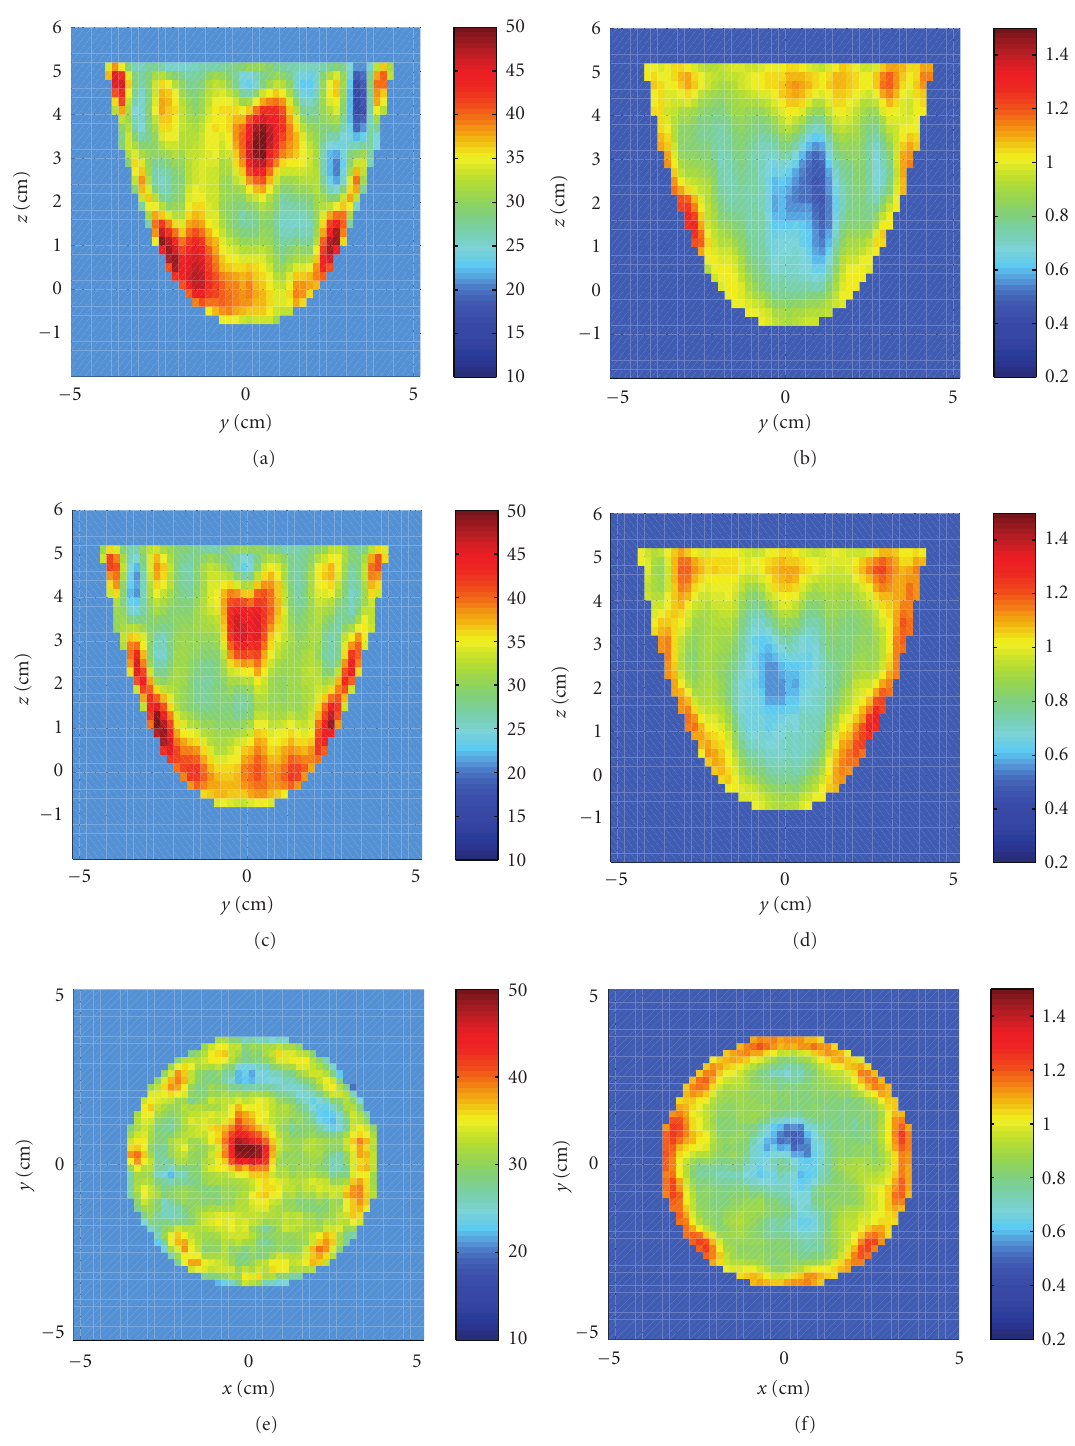
Figure 15: Reconstructions of the HFSS numerical breast phantom in Example 2 after four iterations. (a), (c), and (e) and (b), (d), and (f) Relative permittivity and conductivity, respectively. (a) and (b), (c) and (d), and (e) and (f) Cuts at x = 0cm, y = 0 cm, and z = 3cm. The relative permittivity of the inclusion is recovered, but both images contain many